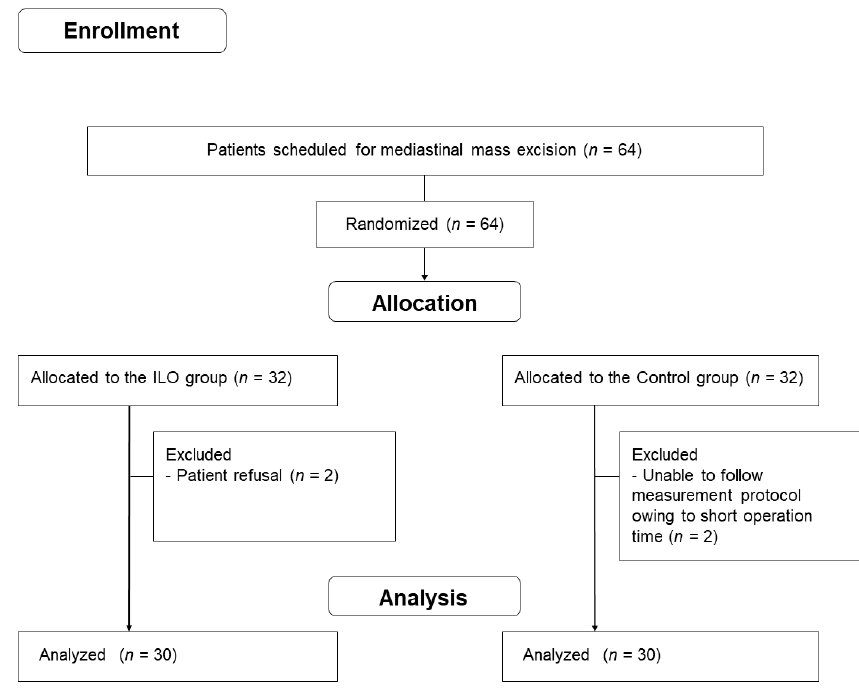
Figure 1. Patient enrollment. Table 1. Preoperative